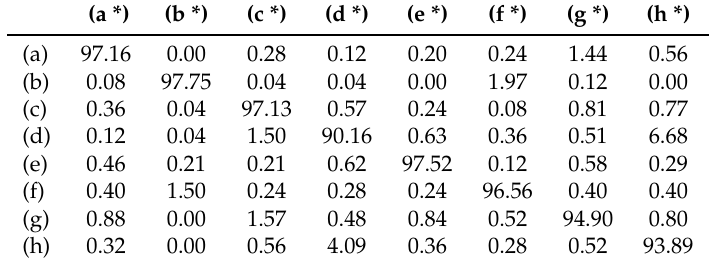
Table 5. The confusion matrix of the modified stacking method (*: Estimated class, Unit: %).